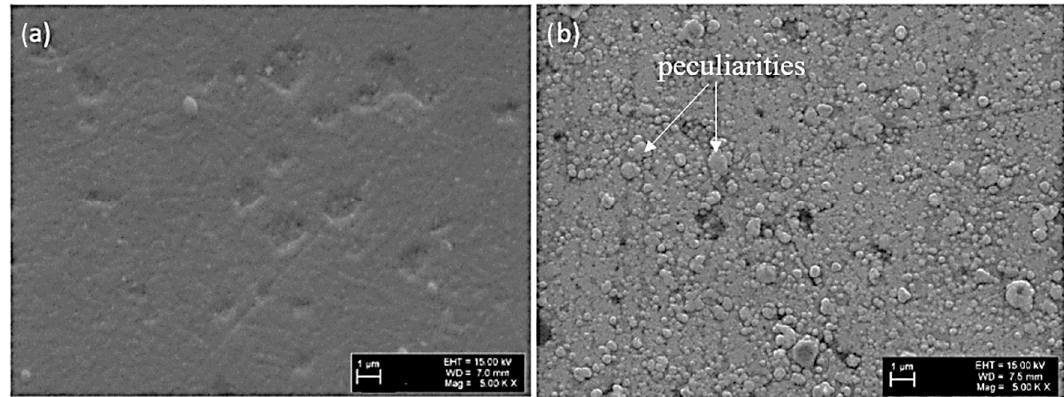
Figure 1. SEM images of the native surface of coatings ( a ) a-C:H:Si and ( b ) Al 2 O 3 /a-C:H:Si.